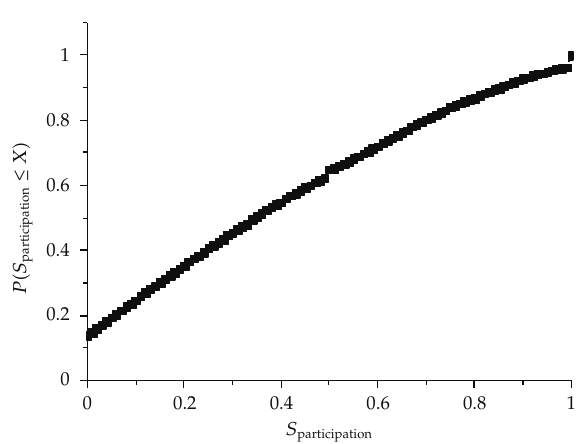
Figure 6: The cumulative probability distribution of S participation of all the users.